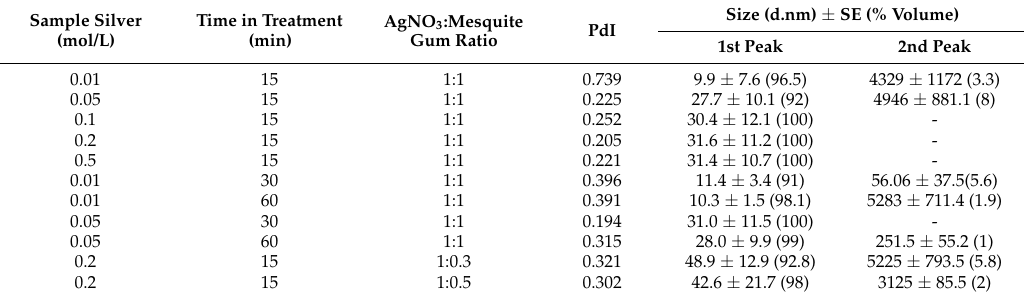
Table 2. Follow-up of the colloidal stability of Ag NPs samples synthesized at different conditions after one month of synthesis: hydrodynamic diameter (DLS